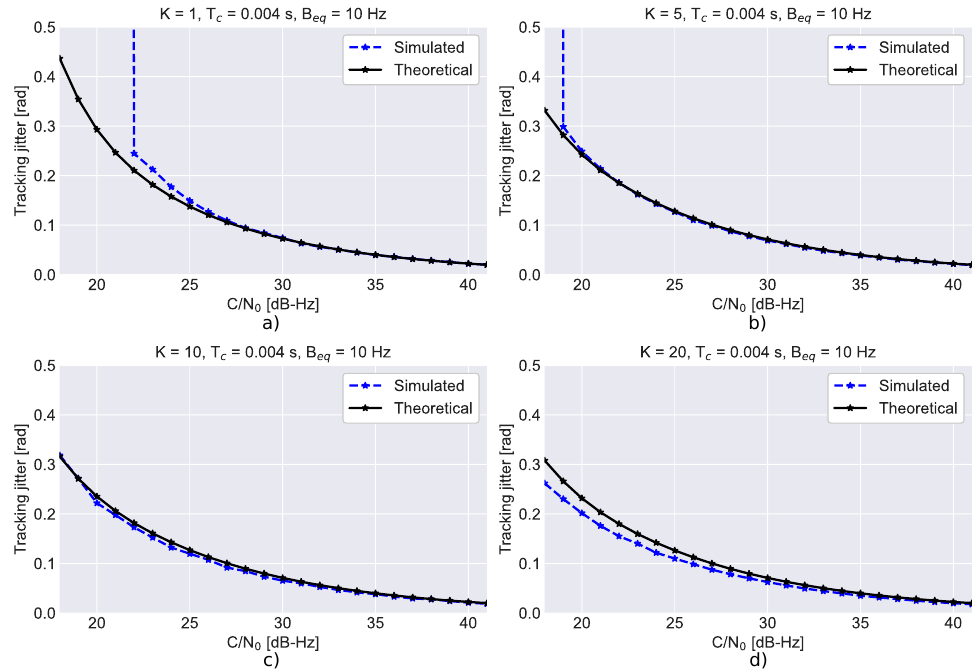
Figure 3. Comparison between the theoretical tracking jitters and simulation results for different non-coherent integrations. ( a ) K = 1, ( b ) K = 5, ( c ) K = 10, ( d ) K =